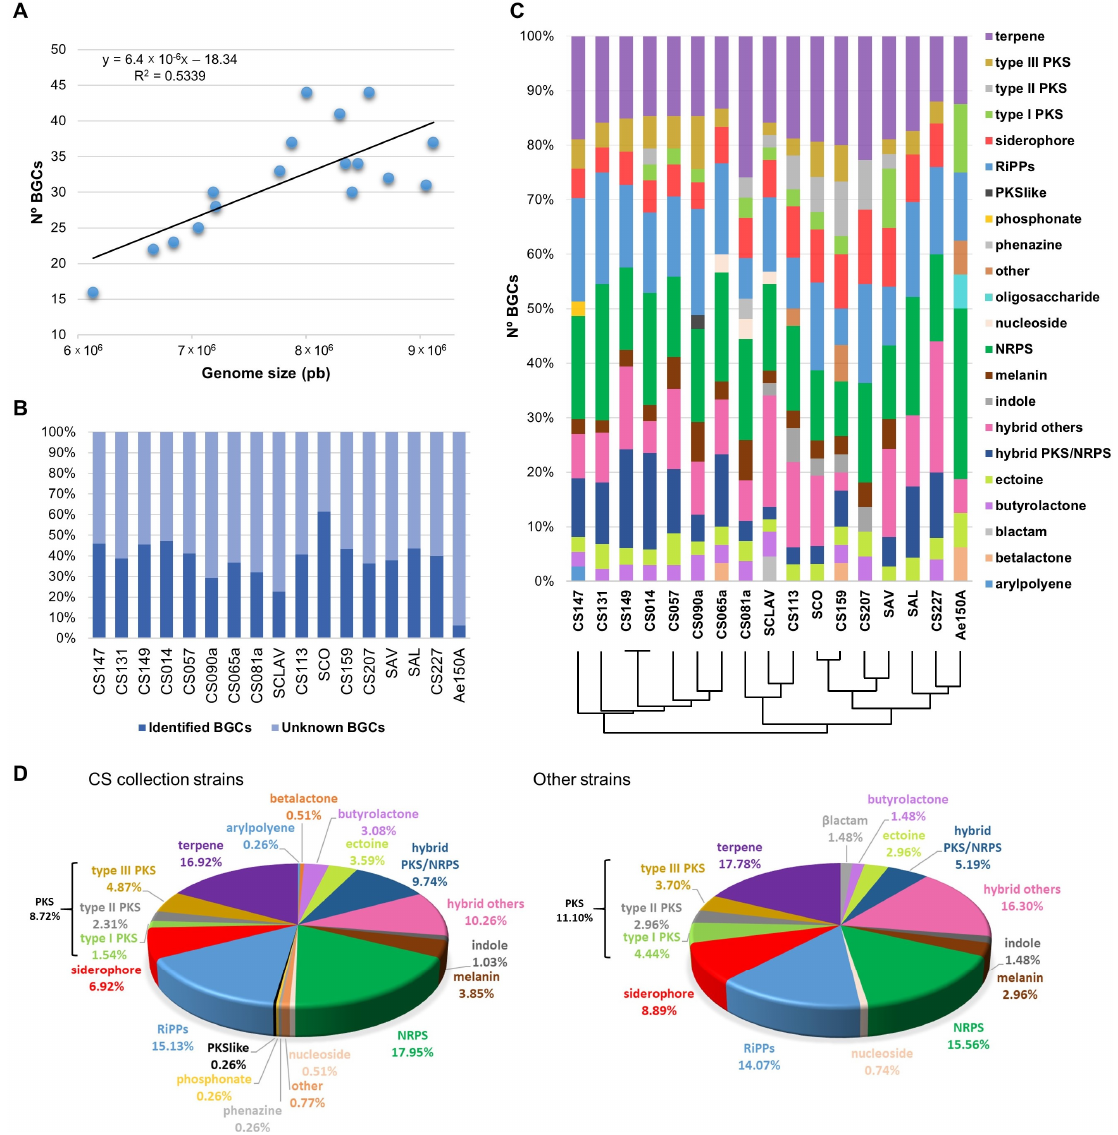
Figure 2. Analysis of the BGCs detected in the 17 strains under study. ( A ) Relationship between genome size and the number of BGCs per genome. ( B ) Frequency of unknown BGCs versus identified BGCs per genome. ( C ) Inter-strain distribution of the 22 major classes of BGCs. ( D ) BGC type distribution among the ‘CS collection group” and the rest of the reference Streptomycete